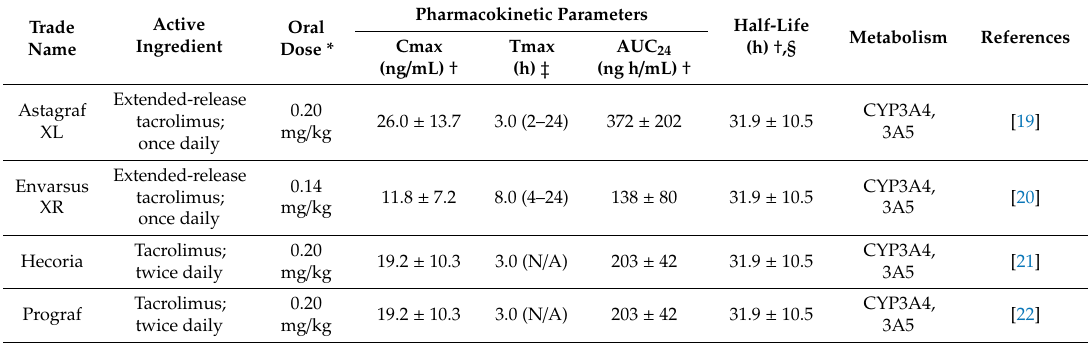
Table 1. Pharmacokinetics of available formulations of tacrolimus in the United